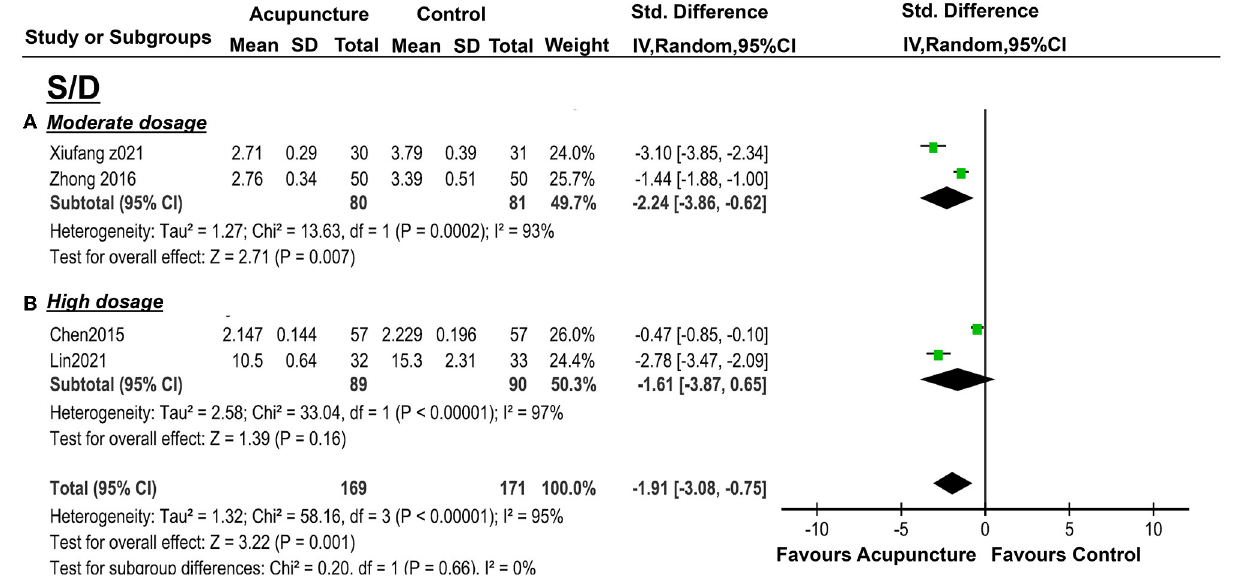
FIGURE 9 | Effects of acupuncture on S/D based on intervention of moderate dosage (A) and high dosage (B) .